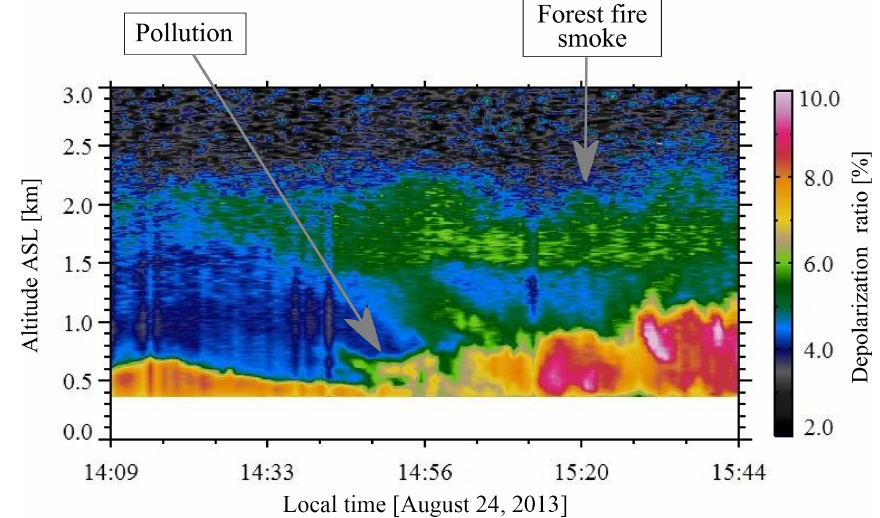
Figure 13. Ground-based lidar depolarization ratio measurements acquired with the ECCC ground-based lidar system located at 57.14 ◦ N, 111.6 ◦ W (AMS 13 in Fig. 11).